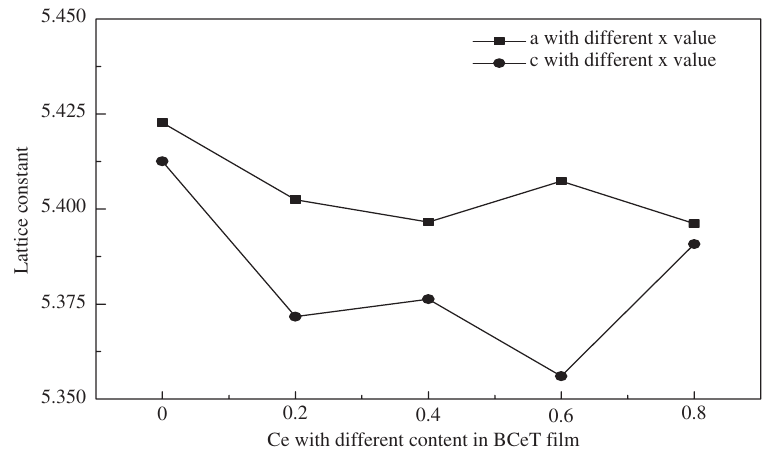
Figure 5 The lattice parameter with different Ce contents annealed at 700 °